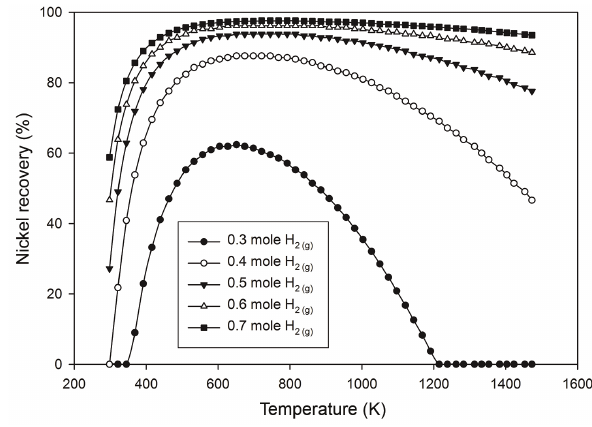
Figure 7: Effect of temperature on the nickel recovery for reduction of the calcined ore for various amounts of hydrogen per 100 kg of ore.